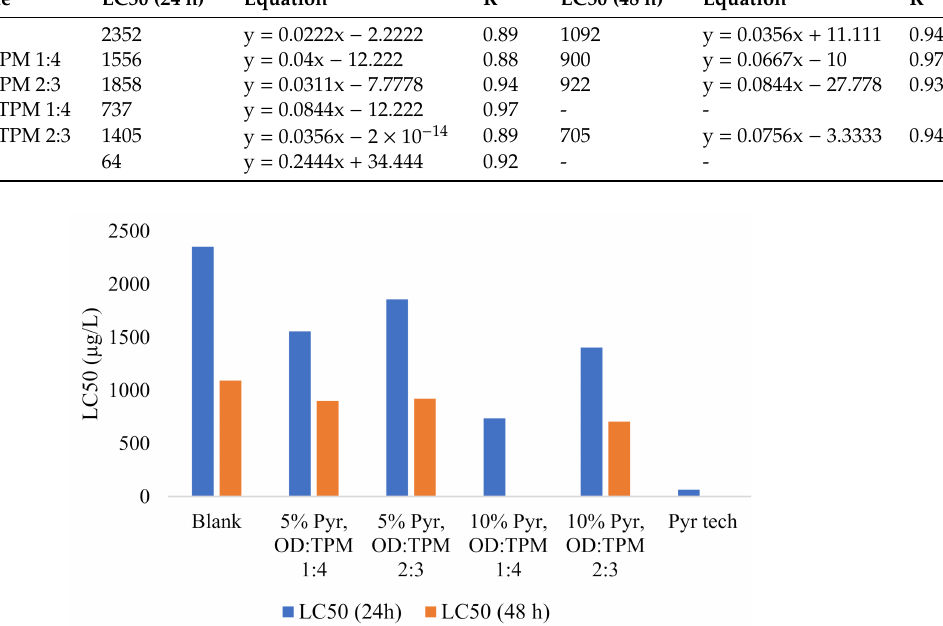
Figure 10. Toxicity of PyrSMCs with various compositions to Artemia